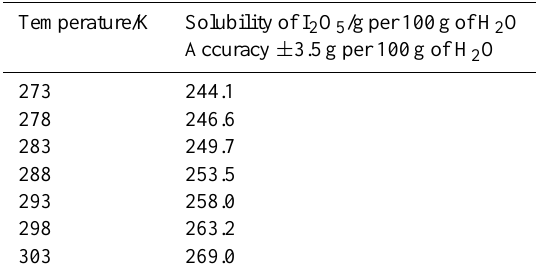
Table 4. Calculated aqueous solubility of I 2 O 5 from 273–303K. These values are derived from our water activity and deliquescence measurements (see text).